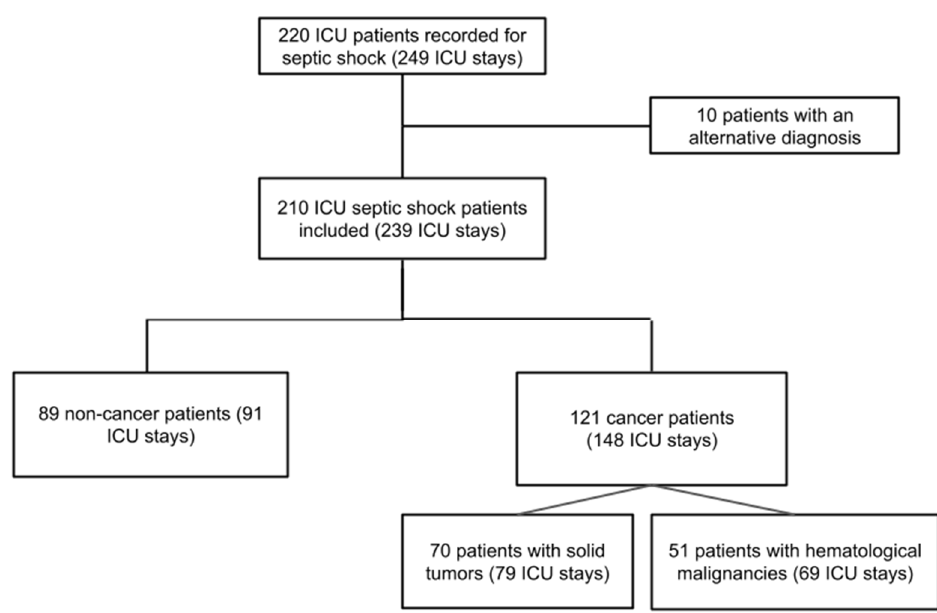
Figure 1. Flowchart of the study population. Abbreviations: ICU, intensive care unit.